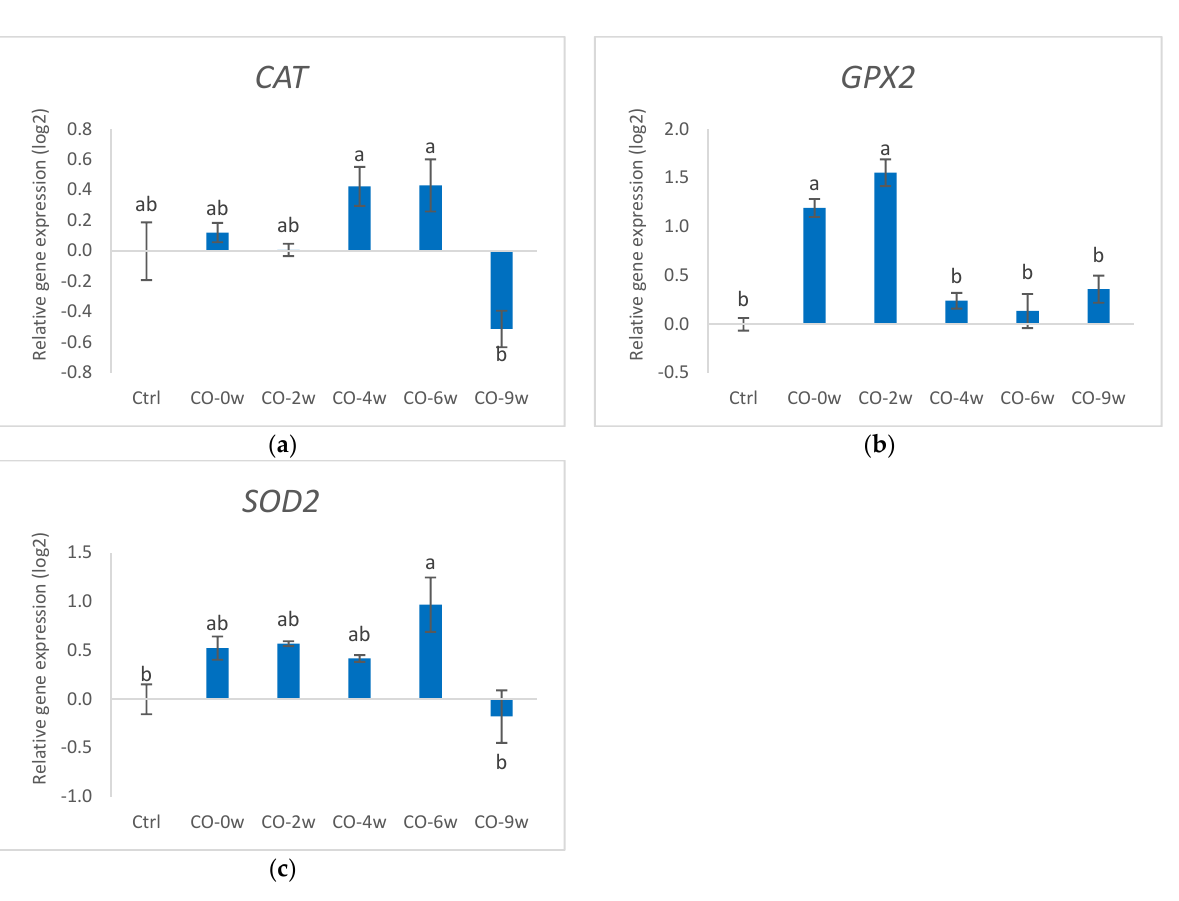
Figure 2. Relative gene expression (log) of markers for antioxidant defence: ( a ) CAT, ( b ) GPX2, and ( c ) SOD2 in HT29 cells exposed to oxidized camelina oil. All groups, except the control group (Ctrl), were cultured in growth media containing 0.5 mg/mL oxidized camelina oil for 72 h. Data (n = 4) are means shown with standard error mean. Significant differences are indicated with different letters evaluated with Tukey–HSD ( p < 0.05). CO = camelina oil; w = weeks.